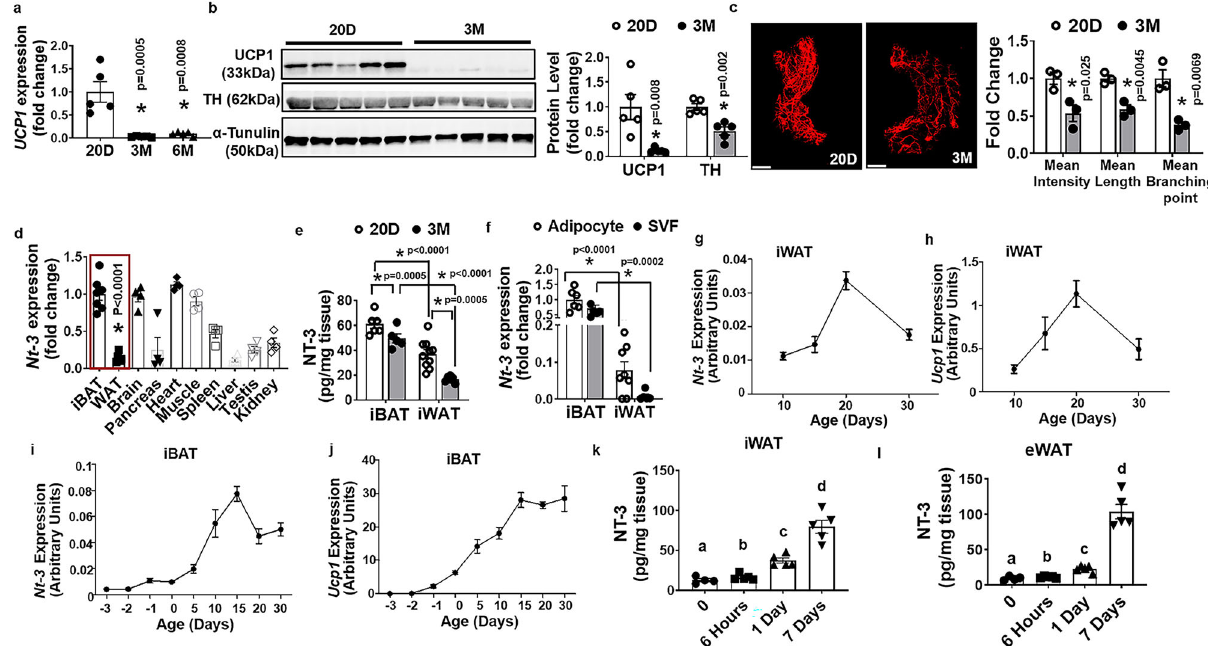
Fig. 1 Adipose-derived neurotrophic factor NT-3 correlates with UCP1 expression and sympathetic innervation in adipose tissue. a Ucp1 mRNA expression in iWAT of 20-day-old postnatal pups, and 3- and 6-month-old mice ( n = 5/group, one-way ANOVA, F (2,12) = 18.04, P = 0.0002, *indicates statistical signi fi cance vs. 20D with Turkey ’ s multiple comparisons test). b UCP1 and TH protein levels in iWAT of 20-day-old postnatal pups and 3-month- old adult mice ( n = 5/group, * indicates statistical signi fi cance vs. 20D using unpaired two-tailed t test). c Representative images of TH-positive sympathetic nerve innervation in iWAT (left panel, from three replicates/group, scale bar = 2000 µ m) and quantitation of mean nerve fi ber density, mean nerve fi ber length, and mean branching points normalized to total adipose tissue area (right panel) in iWAT of 20-days-old postnatal pups and 3-month- old adult mice ( n = 3/group, * indicates statistical signi fi cance vs. 20D using unpaired two-tailed t test). d Tissue distribution of Nt-3 expression (iBAT n = 7; iWAT n = 5; others n = 4) (* P < 0.0001 iWAT vs iBAT with unpaired two-tailed t test). e NT-3 prot e in levels measured by ELISA in iBAT and iWAT of 20-day-old postnatal pups and 3-month-old adult mice (iBAT 20D n = 6, 3 M n = 5; iWAT 20D n = 10, 3 M n = 6) (two-way ANOVA, 20D vs 3 M, F (1, 24) = 62.2, P < 0.0001; iBAT vs iWAT, F (1, 24) = 21.95, P < 0.0001. * indicates statistical signi fi cance as shown in ( e ) with Turkey ’ s multiple comparisons test). f The expression of Nt-3 mRNA in adipocytes and stromal vascular fraction (SVF) in iBAT and iWAT (iBAT n = 6; iWAT adipocyte n = 8, SVF n = 5, two-way ANOVA, cell type (adipocyte vs SVF), F (1, 21) = 4.118, P = 0.055; tissue (iBAT vs iWAT), F (1, 21) = 85.65, P < 0.0001. * indicates statistical signi fi cance as shown in ( f ) with Turkey ’ s multiple comparisons test). g , h The expression of Nt-3 ( g ) and Ucp1 ( h ) in iWAT during postnatal development in mice ( n = 4/group). i , j The expression of Nt-3 ( i ) and Ucp1 ( j ) in iBAT during postnatal development in mice ( n = 4/group). k , l NT-3 protein levels measured by ELISA in iWAT ( k , time 0 n = 4; 6 h, 1d and 7d n = 5) and eWAT ( l , time 0 n = 4; 6 h, 1d and 7d n = 5) during cold exposure. k One-way ANOVA with Turkey ’ s multiple comparisons test, F (3, 15) = 39.79, P < 0.0001. a vs c: time 0 vs 1 day, P = 0.018; a vs d: time 0 vs 7 days, P < 0.0001; b